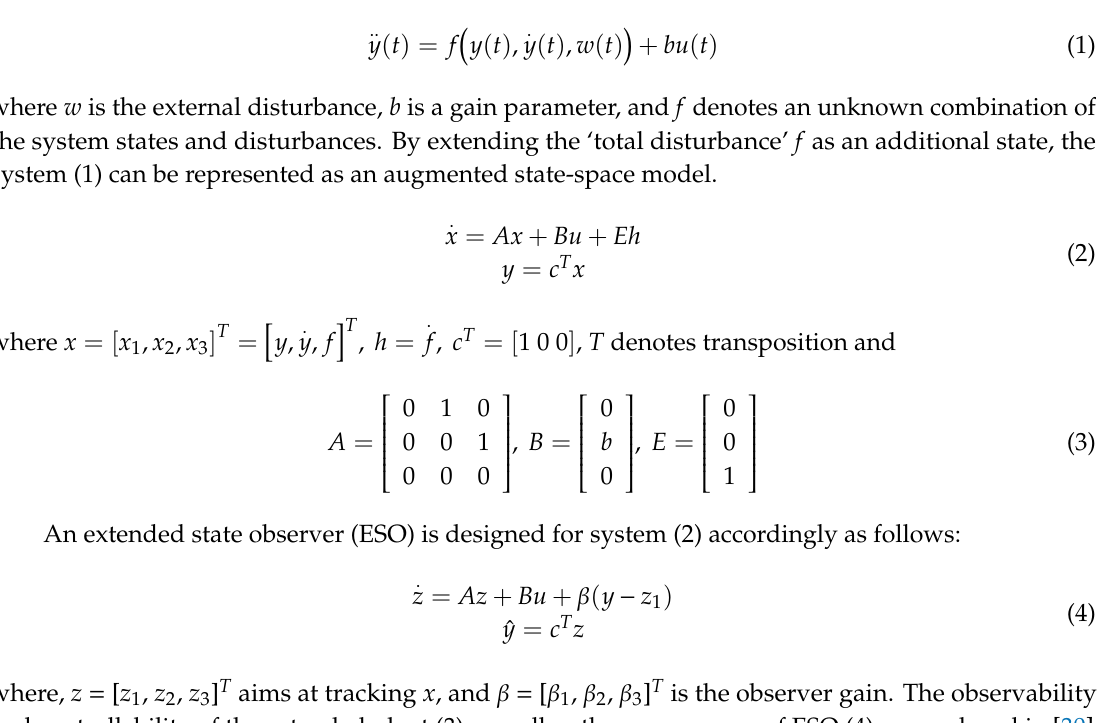
Figure 1. The block diagram of the second-order active disturbance rejection control ADRC.